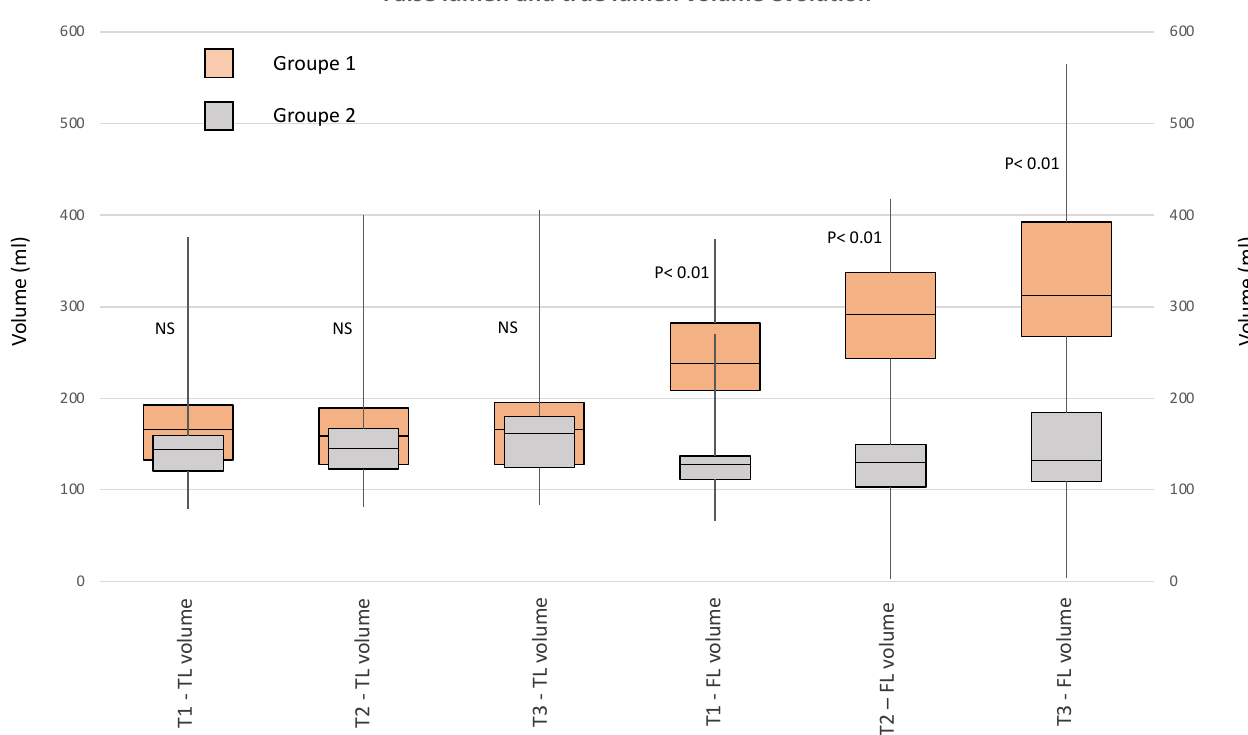
term dissection-related events with a sensitivity of 88% and a specificity of 75% (Figure